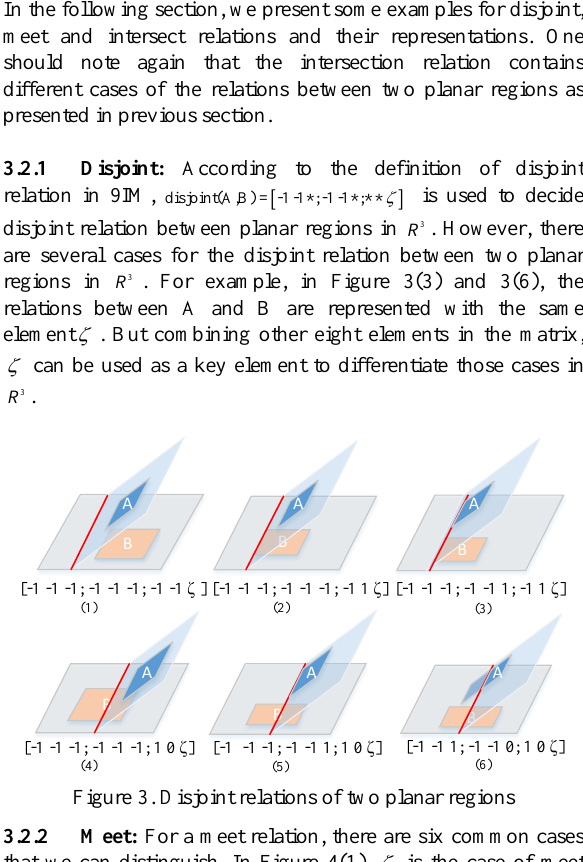
Figure 3. Disjoint relations of two planar